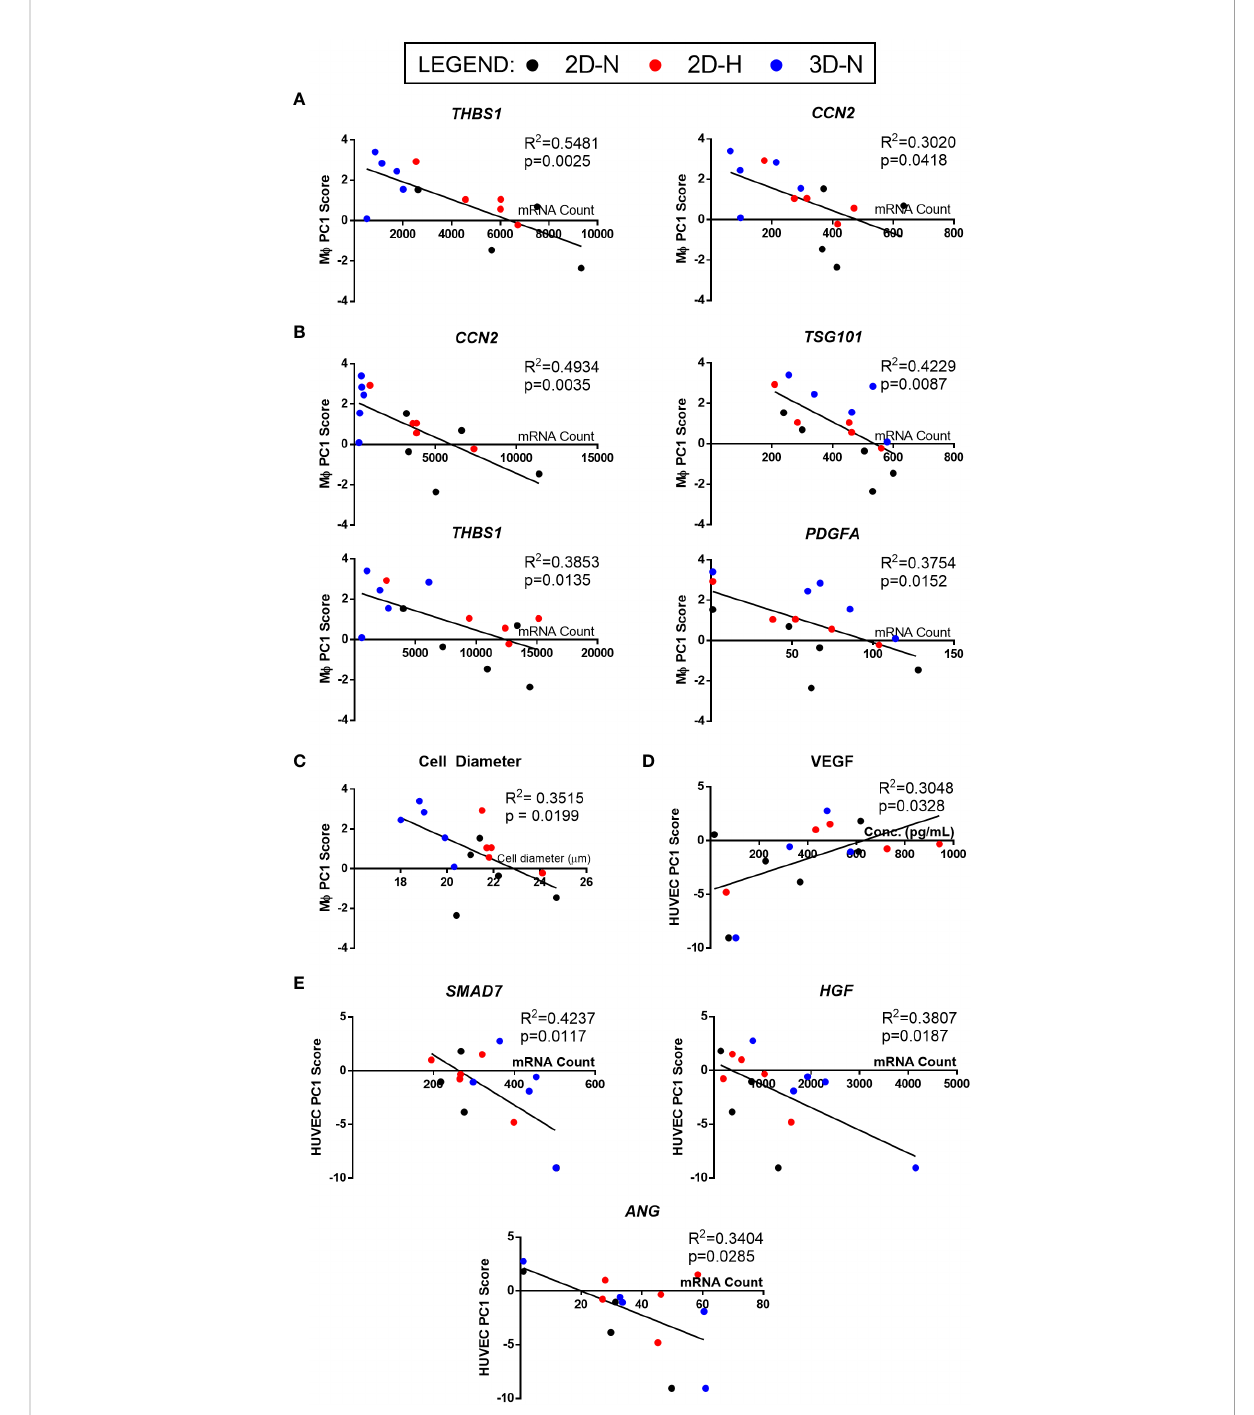
FIGURE 6 Linear regression analysis revealed genes, soluble factors, and morphological features that correlate with anchor functional assays to identify a putative matrix of CQAs for MSC(AT). (A, B) Inverse correlation between PC1 composite scores from M F polarization (Figure 4) and curated panels of MSC(AT) genes measured under Licensed (A) and Unlicensed (B) conditions. (C) Single cell diameter of MSC(AT) inversely correlated to M F polarization PC1 composite scores. (D) Positive correlation between HUVEC tube formation PC1 composite scores (Figure 5) and levels of VEGF protein in MSC(AT) conditioned medium under Licensed conditions. (E) Inverse correlation between HUVEC tube formation PC1 scores and curated panels of MSC(AT) genes measured under Licensed conditions. Only correlations with R 2 ≥ 0.3 are shown. N=14-15. 3D-N, 3D Normoxic culture; 2D-N, 2D Normoxic culture; 2D-H, 2D Hypoxic